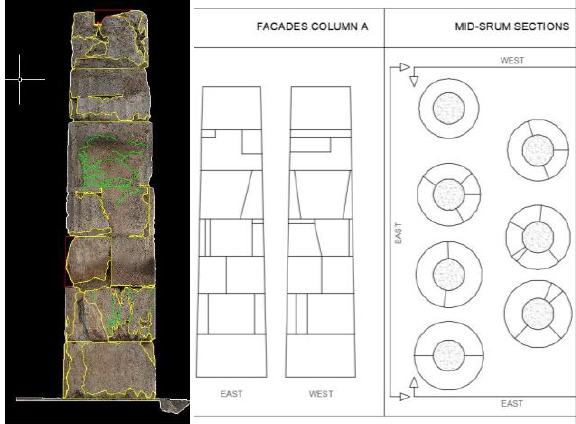
Figure 7: Mesh (surface Figure 8: Texture generation Figure 9: Cracks model) generation